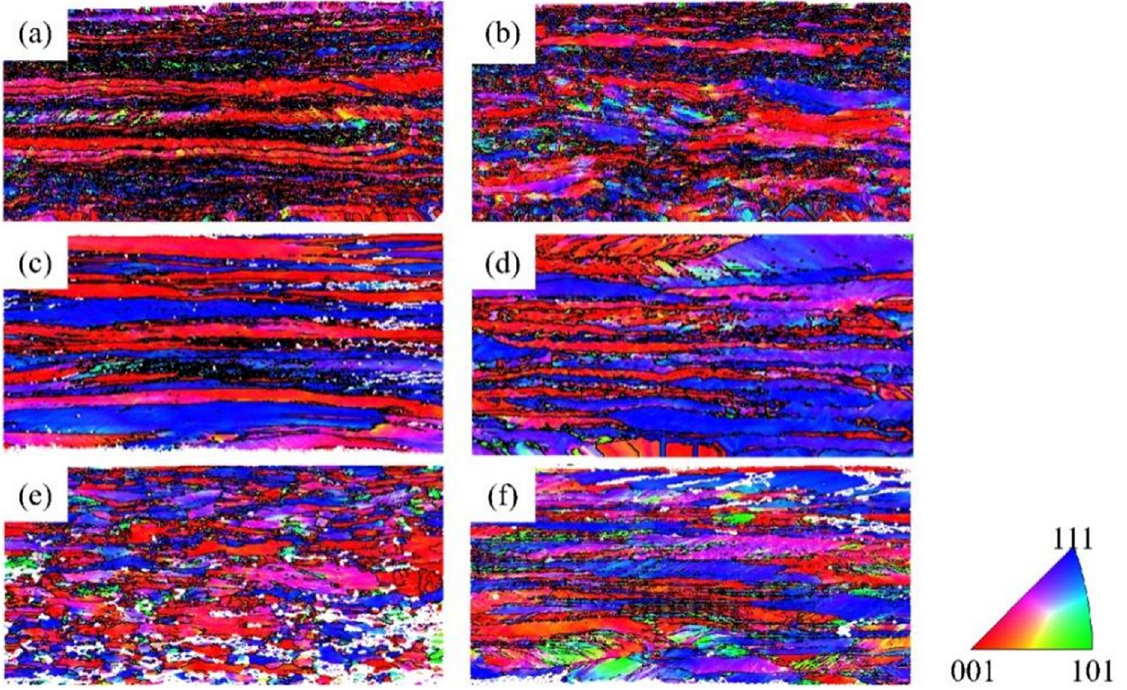
Figure 7: IPF diagram of di ff erent cold - rolling deformation of grain - oriented silicon steel: ( a ) 86% Y - free; ( b ) 86% Y - bearing; ( c ) 72% Y - free; ( d ) 72% Y - bearing; ( e ) 60% Y - free; ( f ) 60% Y -